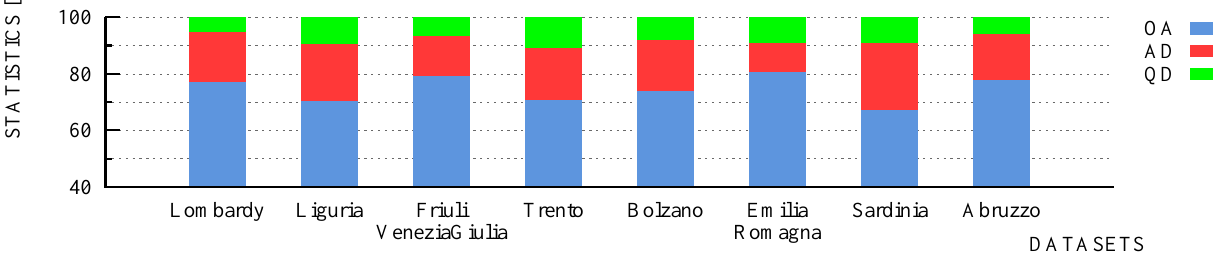
Figure 12. Comparison between GlobeLand30 2000 and Italian regional datasets (II reclassification, no buffer case): overall accuracy (OA), allocation disagreement (AD), quantity disagreement (QD) for each regional dataset.